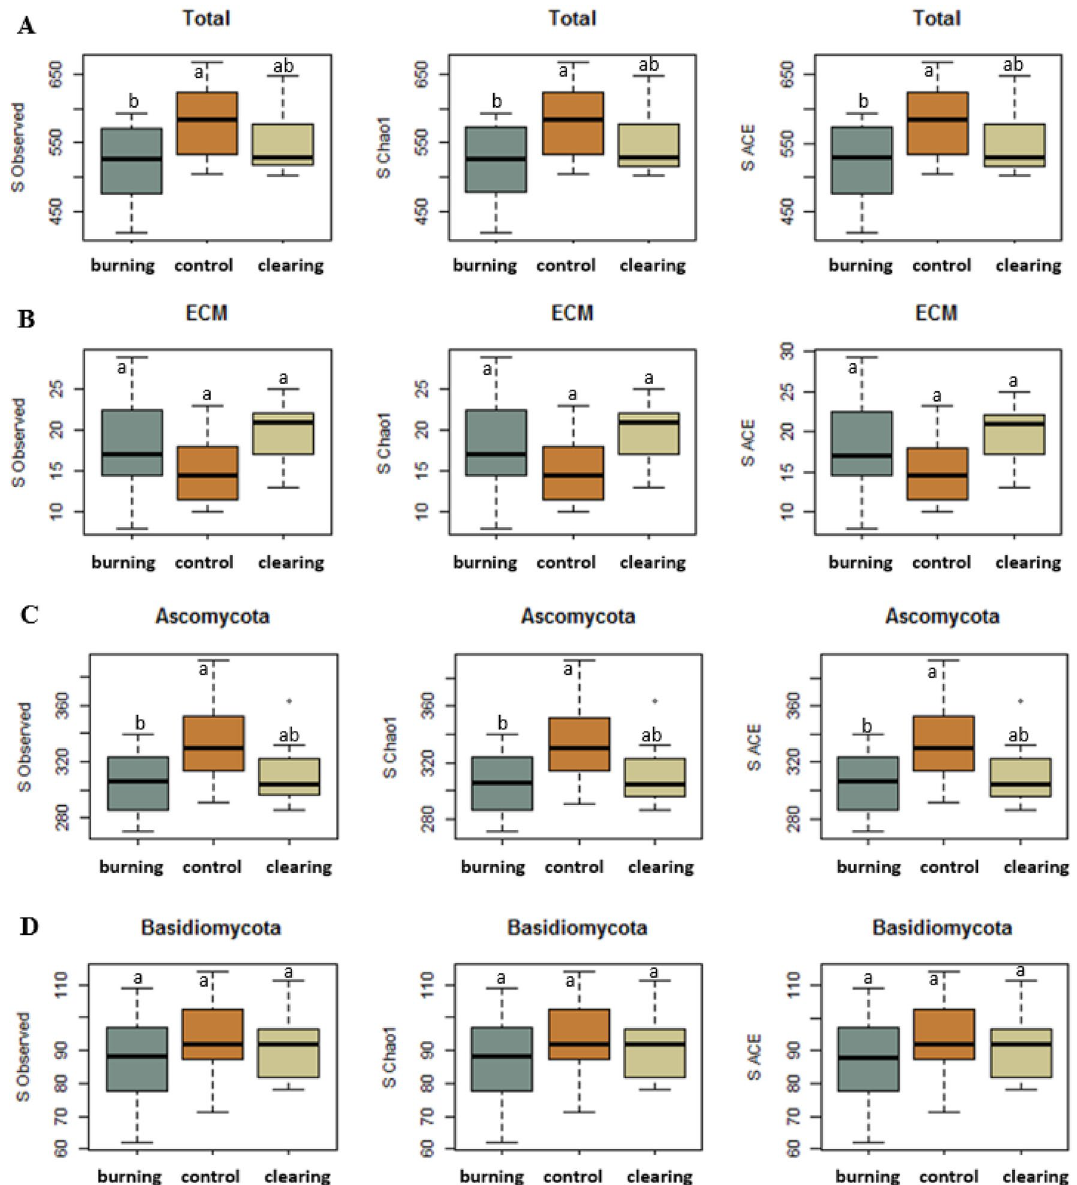
Figure 2. Proportional species richness and richness estimation of total ( A ), trophic guilds ( B ) and fungal phyla ( C,D ) by extrapolating the singleton and doubleton (Chao1) values or rare species (ACE, abundance- based coverage estimator; abundance < 10 species) in soil samples collected 9 years after scrublands were subjected to prescribed burning, mechanical clearing or no treatment (Control). Different lowercase letters above bars indicate a significant difference between treatments ( p <